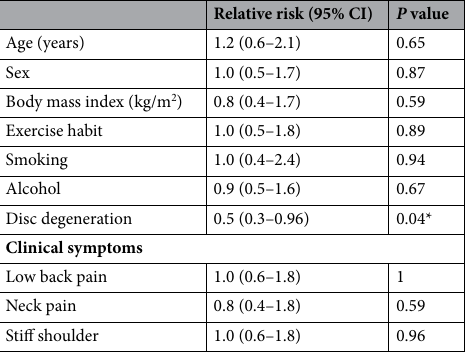
Table 4. Relationship between changes in the luminance of increased CSAs and factors evaluated using univariate analyses. An asterisk indicates statistical significance. 95% CI, 95% confidence interval.